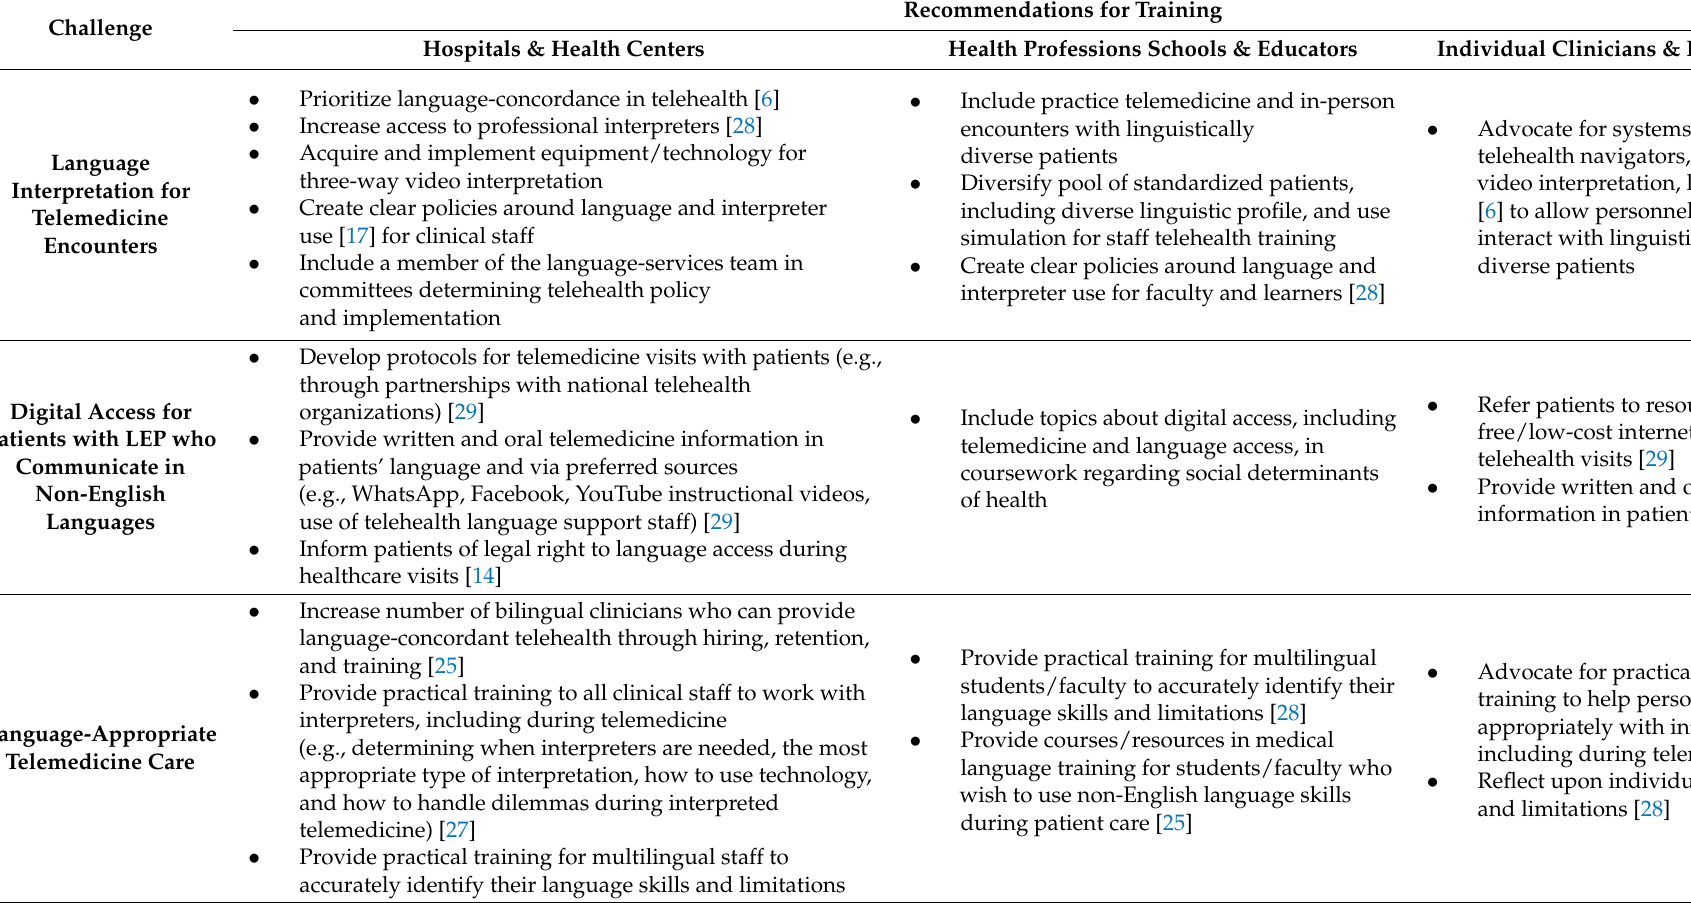
Table 1. Challenges and Recommendations for Training to Improve Language-Appropriate Telemedicine